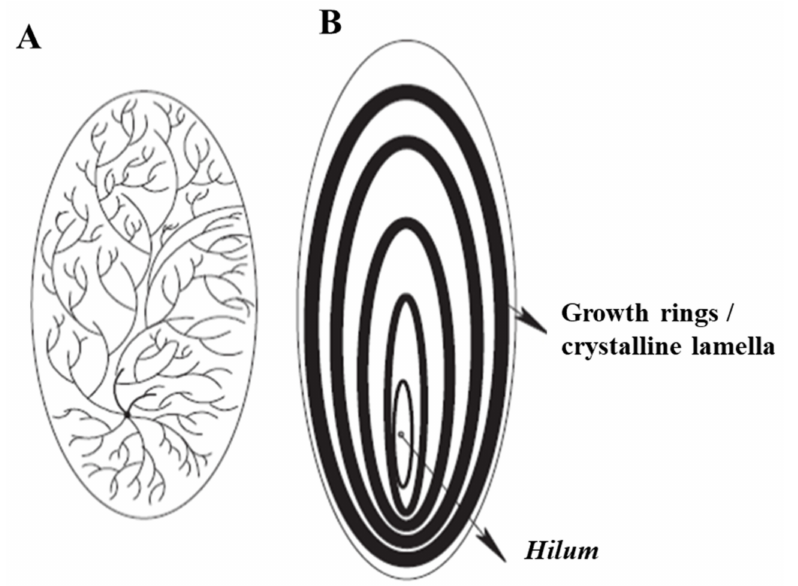
Figure 5. ( A ) Schematic organization of the sweet potato starch granule; ( B ) Central hilum and sweet potato starch granule growth rings. Reproduced from Xijun, Lin [61]; with some modifications.